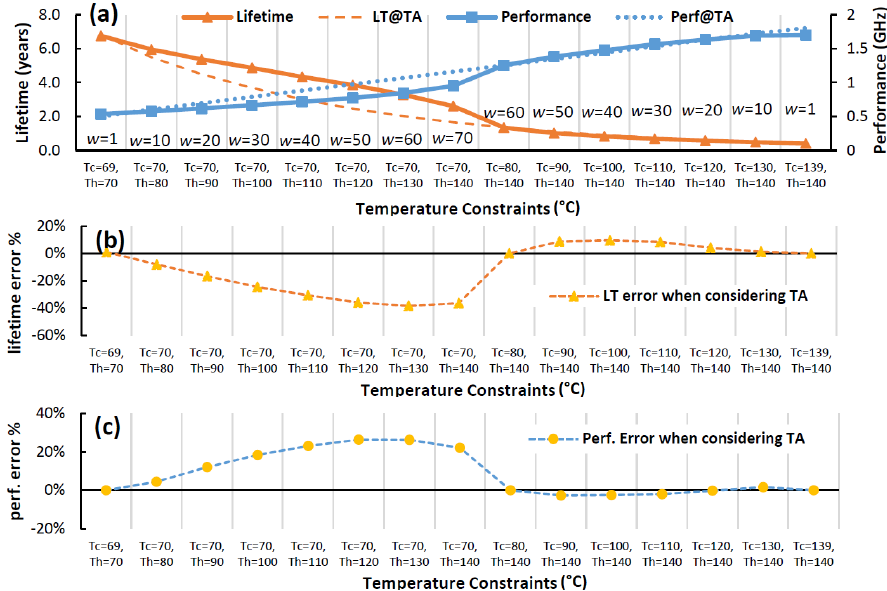
Figure 13. ( a ) Lifetime (left “y”-axis) against performance (right “y”-axis) results for a sliding window w = T h − T c (“x’-axis) that gradually increases in size in the range [70 ◦ C–150 ◦ C]; ( b ) LT error when considering TA; ( c ) performance error when considering